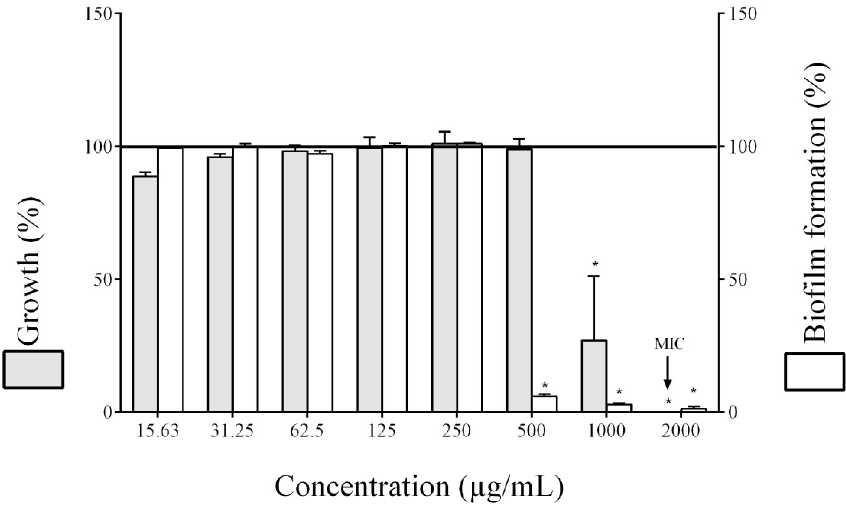
Fig 1. Effect of the cocoa extract on F . nucleatum growth and biofilm formation. A relative value of 100% was assigned to growth and biofilm formation in the absence of the cocoa extract. MIC: minimum inhibitory concentration. � , significant inhibition ( p < 0.01) compared to the control (no cocoa extract).